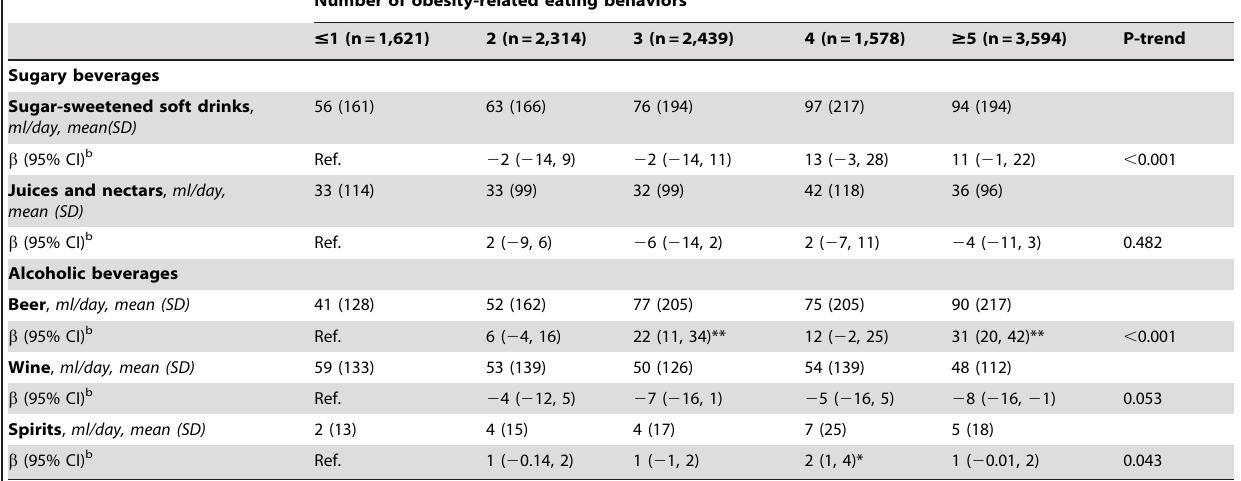
Number of obesity-related eating behaviors